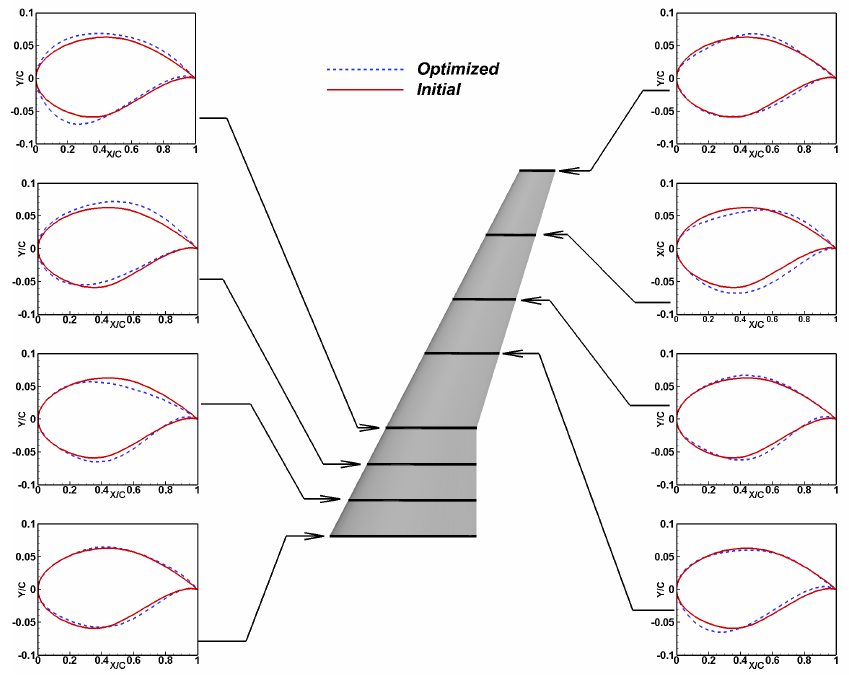
Figure 10. Comparison of initial and optimized wing-section